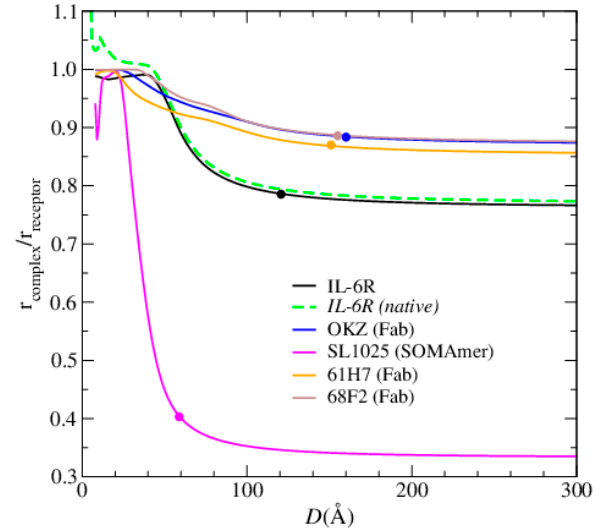
Figure A2. Relative resistance of IL-6 complexed with different receptors; contacts on the receptor. The dashed line describes the relative resistance of IL-6 complexed with IL-6R vs. IL-6R in its native state (PDB ID: 1n26 [47]).